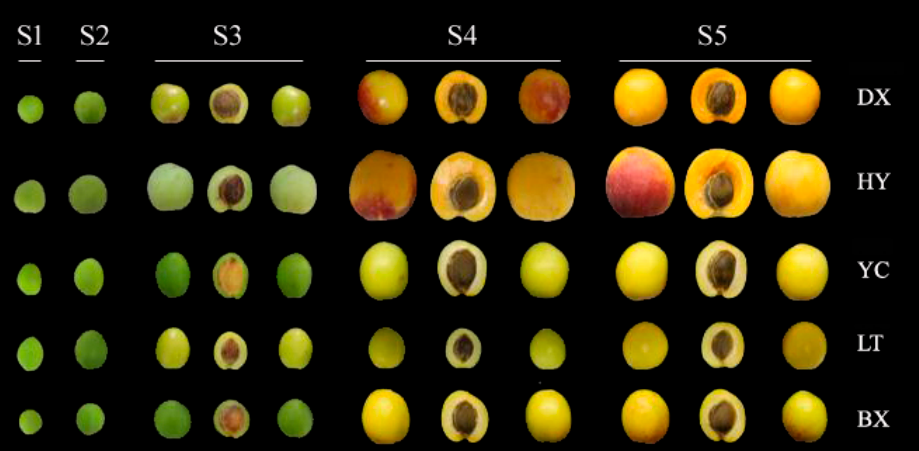
Figure 1. Morphology of apricot fruit during development and ripening. The sampling time for each stage is listed in Table 1. They are represented by immature green (S1); maturation green (S2); turning (S3); green ripe (S4) and full ripe (S5). Cultivar abbreviations (as listed in Table 1) are shown at right.